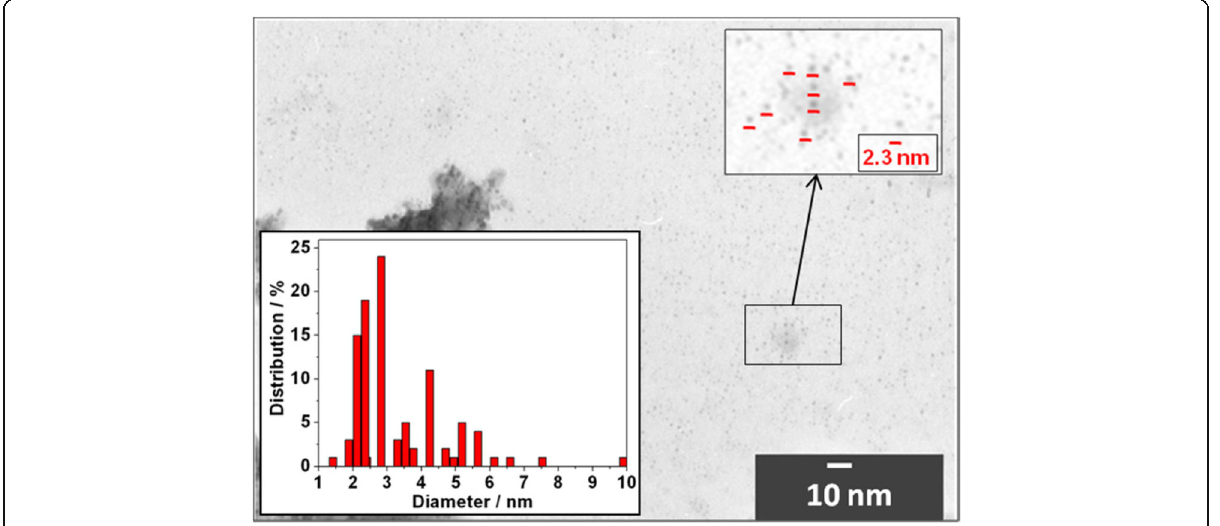
Fig. 1 TEM image of Cd 0.91 Mn 0.09 Te-alloyed QDs. Inset: histogram illustrating the Cd 0.91 Mn 0.09 Te-alloyed QD diameter